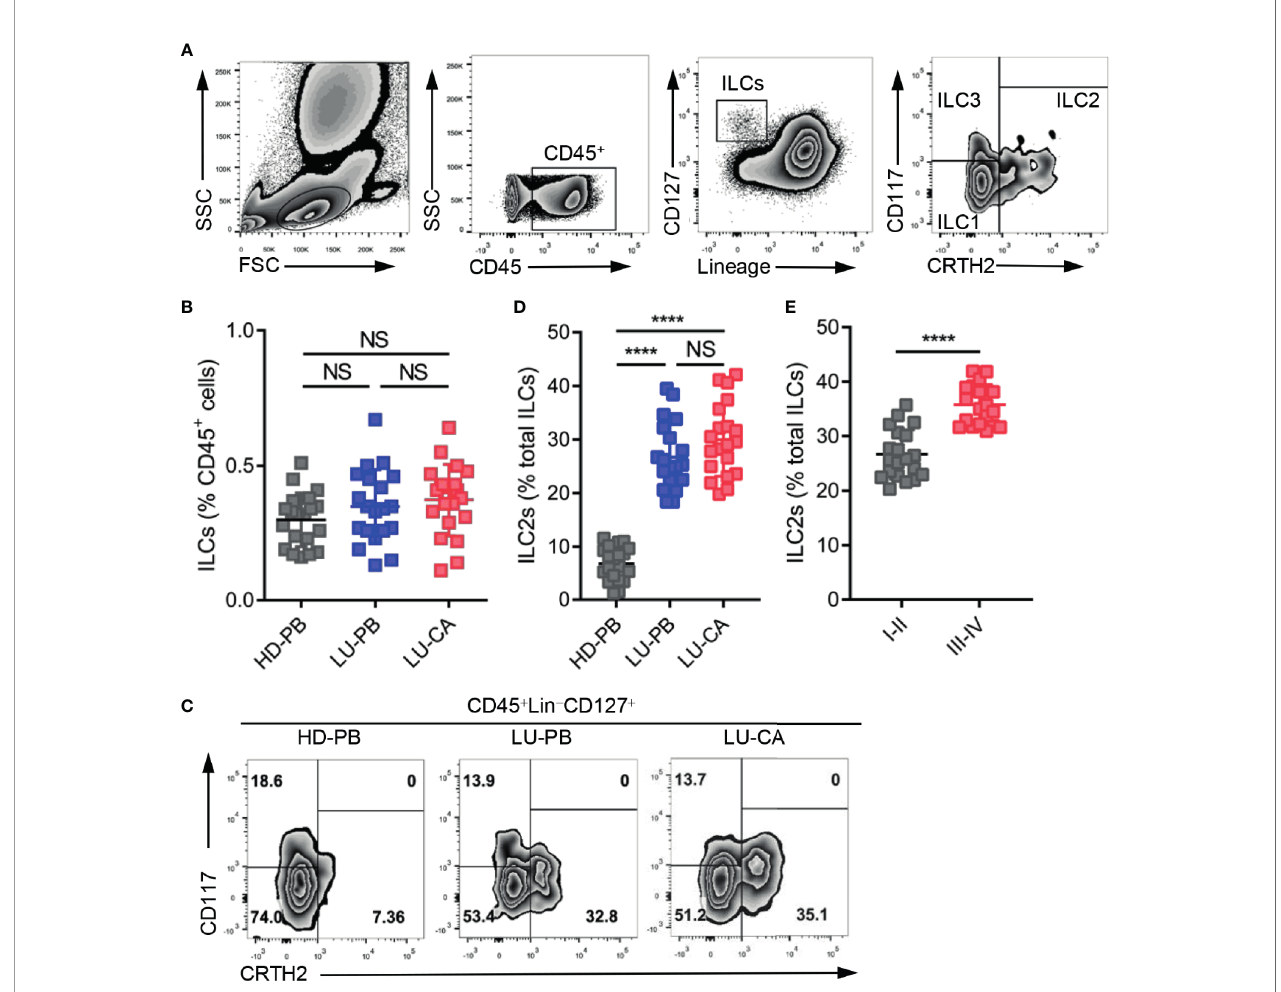
FIGURE 1 | Identi fi cation and distribution of group 2 innate lymphoid cells in healthy donors and NSCLC patients. (A) The representative gating strategy of human ILCs (CD45 + Lin (CD3, CD14, CD16, CD19, CD20, CD56) - CD127 + ). ILC1s: CD45 + Lin - CD127 + CRTH2 - CD117 - ; ILC2s: CD45 + Lin - CD127 + CRTH2 + ; ILC3s: CD45 + Lin - CD127 + CRTH2 - CD117 + . (B) The proportions of total ILCs among CD45 + cells from HD-PB (PBMCs from healthy donors, n=20), LU-PB (PBMCs from NSCLC patients, n=20), and LU-CA (tumor single cell suspension from NSCLC patients, n=20). (C) The representative results of ILC subset distribution in HD-PB, LU-PB, and LU-CA samples assessed via fl ow cytometry. (D) The proportions of ILC2s among total ILCs in HD-PB, LU-PB, and LU-CA (for each group, n=20). (E) The proportions of ILC2s among total ILCs of LU-CA at different stages (for each group, n=20). NS, not signi fi cant; **** P <0.0001. In (B, D) , P values were calculated by one-way ANOVA and post hoc comparisons were performed via Tukey ’ s test. In (E) , P values were obtained in a non-paired two-tailed student ’ s t